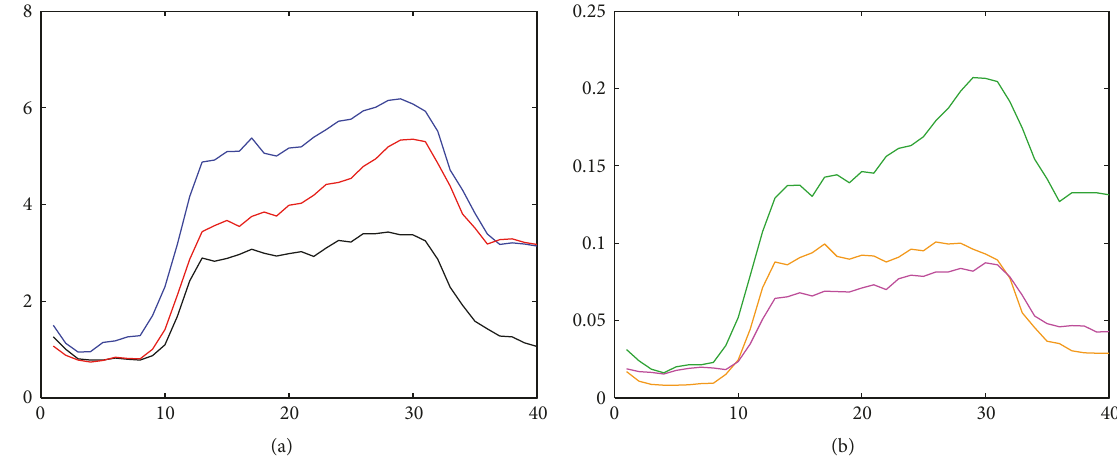
Figure 7: (a) The GACS values for European (blue line), Asian (black line), and American (red line) groups. (b) ACGCS values for the three groups: Europe–America group (green line), Asia–Europe group (yellow line), and America–Asia group (magenta line).